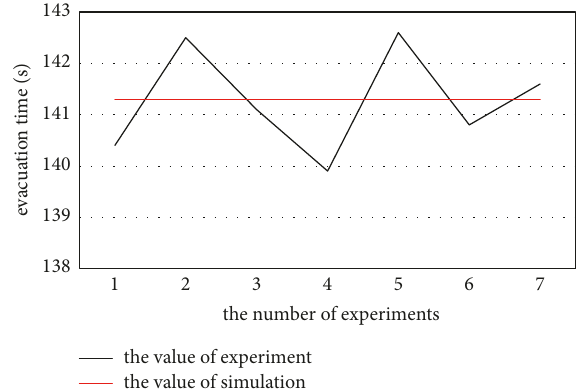
Figure 6: The difference between experimental evacuation time and simulated evacuation time.